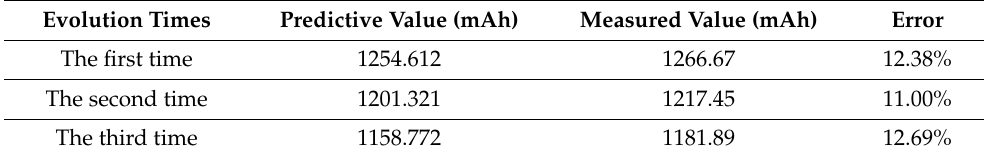
Table 7. The result of model evolution with fixed cycles.